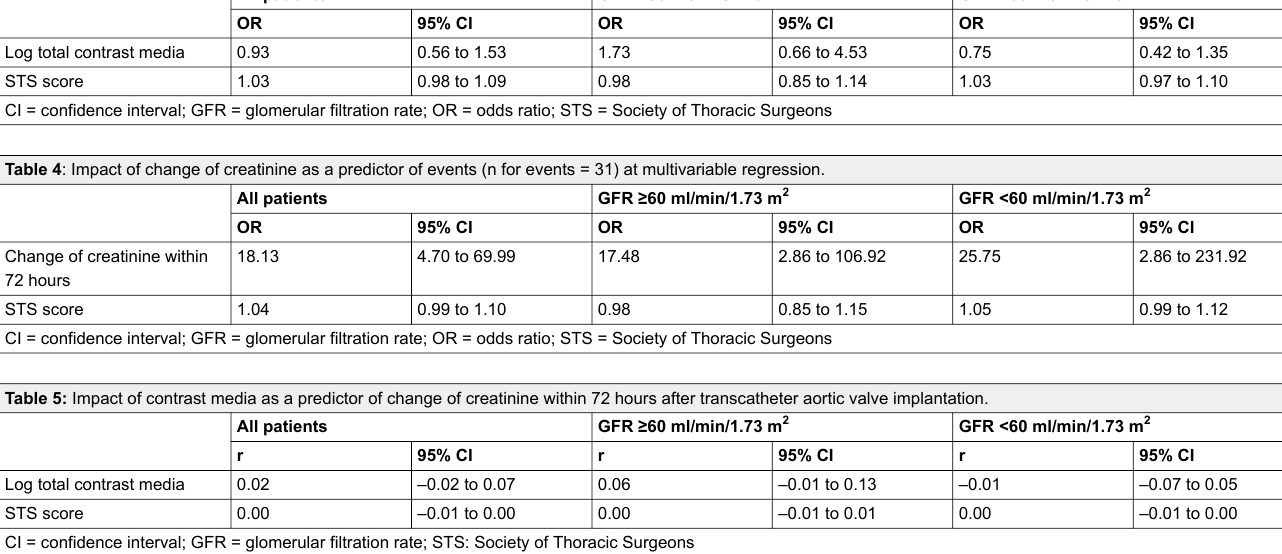
Table 3: Impact of contrast media as a predictor of events (n for events = 31) at multivariable regression. All patients